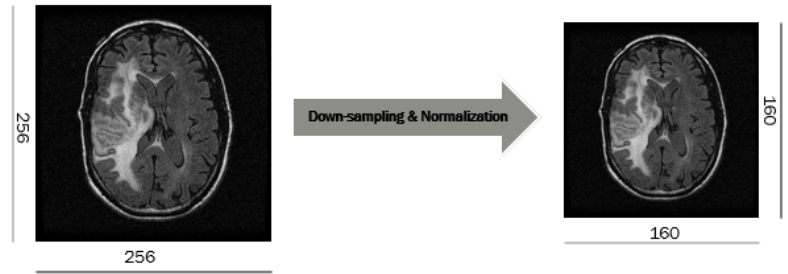
Figure 5. Down-sampling and normalization of MR images.